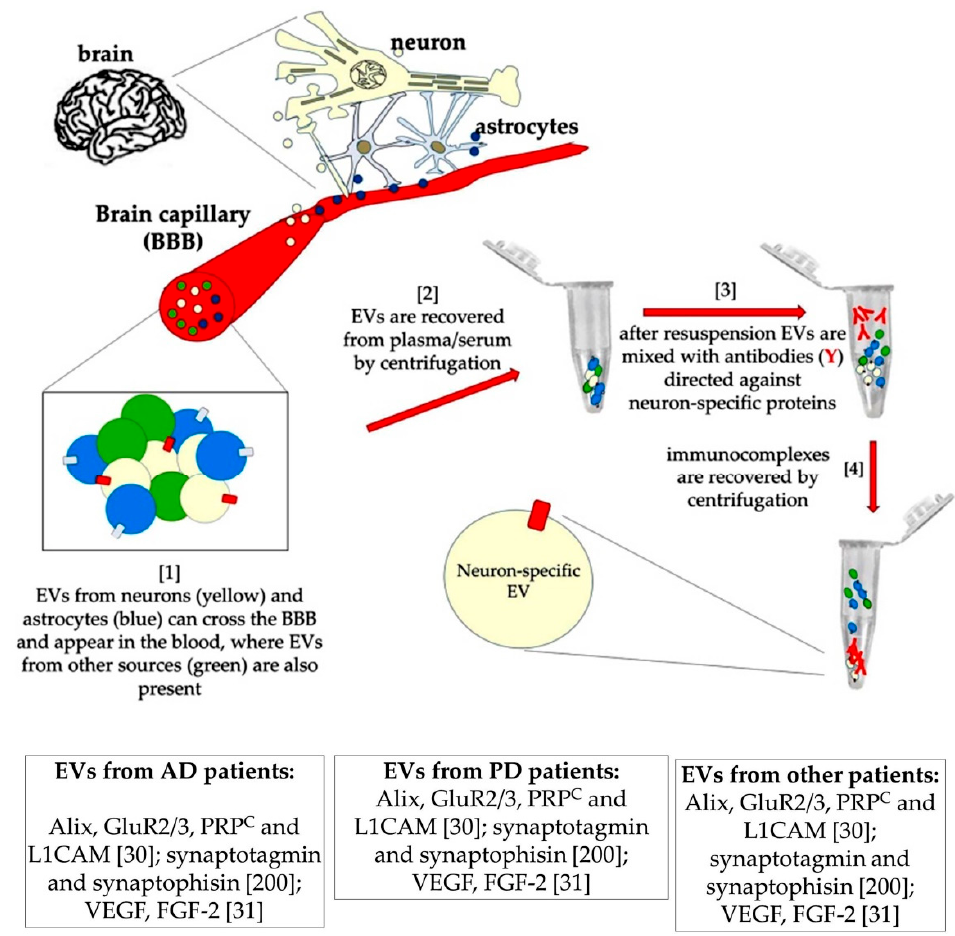
Figure 7. Schematic drawing of a procedure for purifying neuron-derived EVs, according to [250]. A few molecules that have been found increased (upward arrows) or decreased (downward arrows) in EVs purified from the blood of patients are reported in the boxes, together with some relevant references